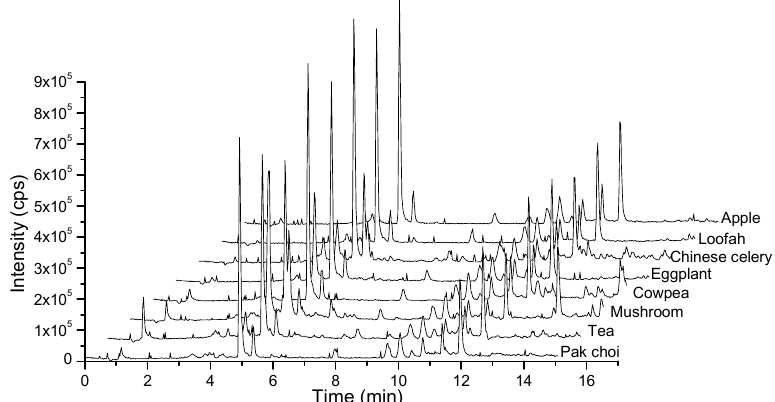
Figure 7. Typical total ion chromatograms of fifteen carbamates at 2 μg/kg spiked in eight matrices (cleaning by 50 mg C18 and 150 mg PSA). Table 3. Matrix effects of the fifteen carbamates pesticides in distinct samples. Compound